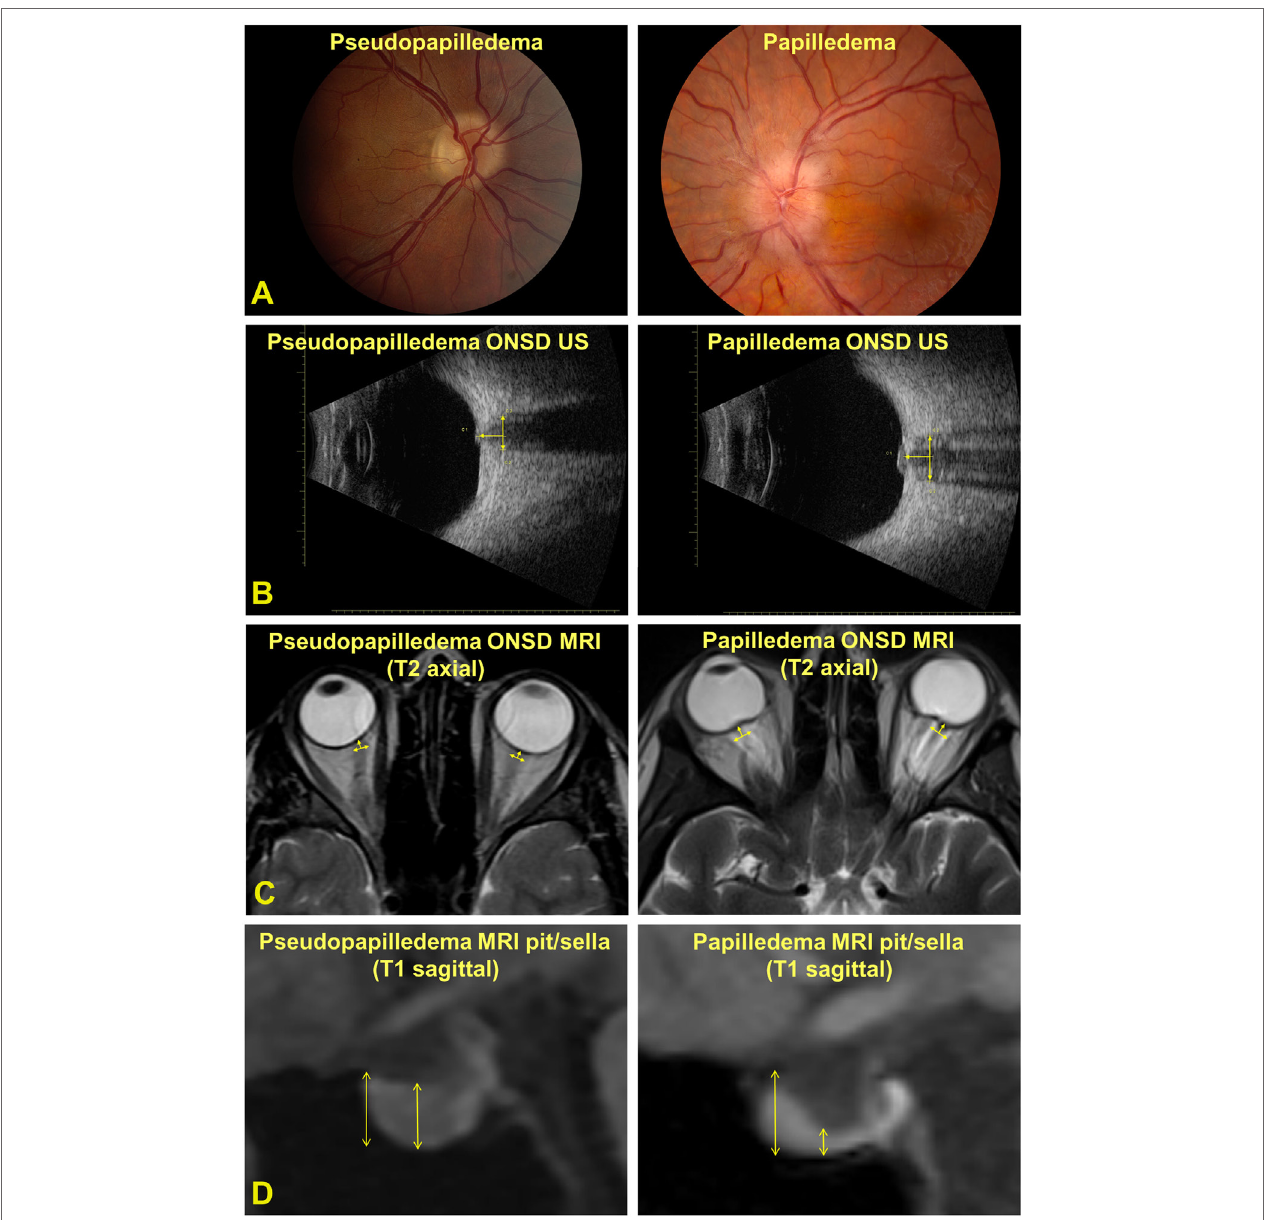
FigUre 1 | (a) Photographs of an optic nerve with pseudopapilledema (left panel) and papilledema (right panel). (B) ultrasonography- (US) measured optic nerve sheath diameter (ONSD) measured 3 mm posterior to the inner scleral surface. (c) Magnetic resonance imaging (MRI)-measured ONSD 3 mm posterior to the inner scleral surface. (D) MRI-measured pituitary (pit) and sella turcica (sella)